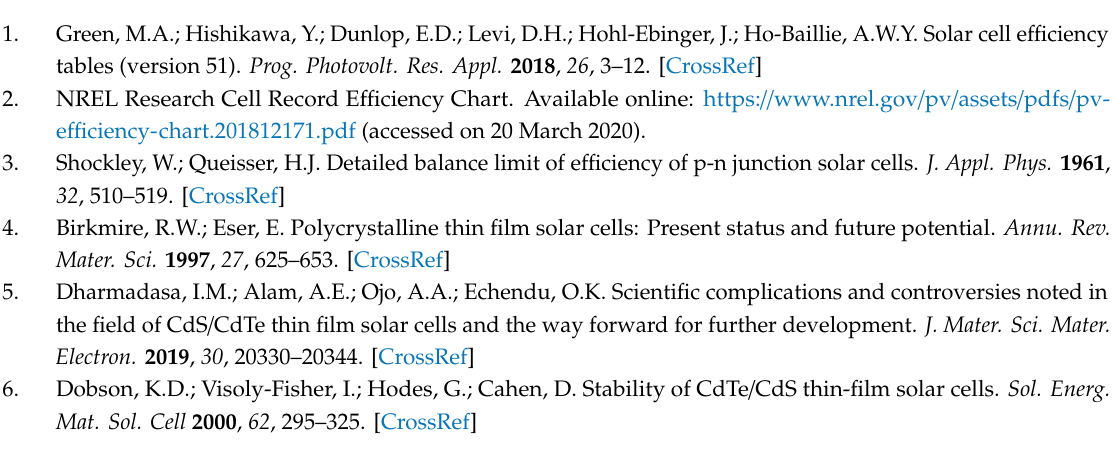
Figure S1: Cross-sectional SEM images of complete devices with CuSCN as back contact in di ff erent magnification, Figure S2: J-V curves the best cells in devices with di ff erent CuSCN thickness, Figure S3: Statistical results for MZO / CdTe solar cell performances of ( a ) PCE, ( b ) V OC , ( c ) FF, (d) JSC, ( e ) series resistance (R S ), and ( f ) shunt resistance (R SH ) with di ff erent CuSCN solutions, Figure S4: Statistical results for MZO / CdTe solar cell performances of ( a ) PCE, ( b ) V OC , ( c ) FF, ( d ) JSC, ( e ) series resistance (R S ), and ( f ) shunt resistance (R SH ) with di ff erent CuSCN